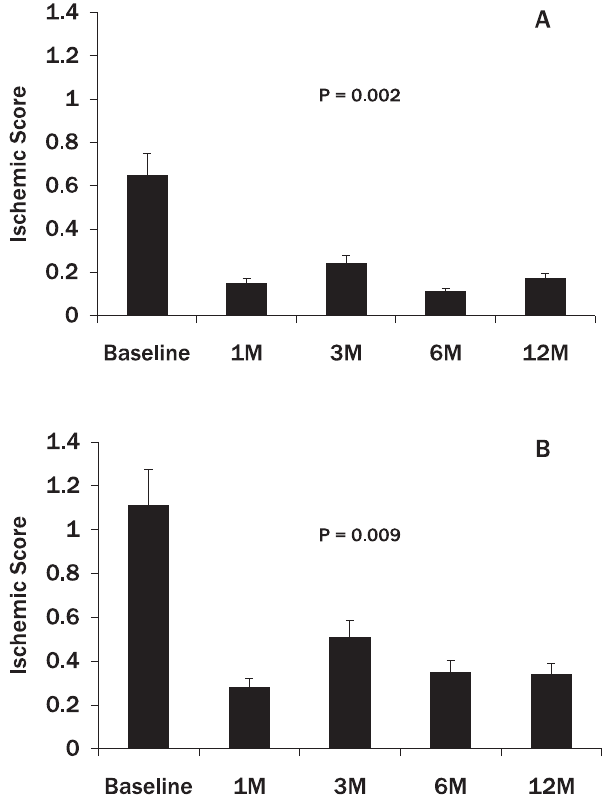
Figure 2 - Total (A) and regional (B) LV ischemic scores as assessed by MRI at baseline and during the first year after injection of